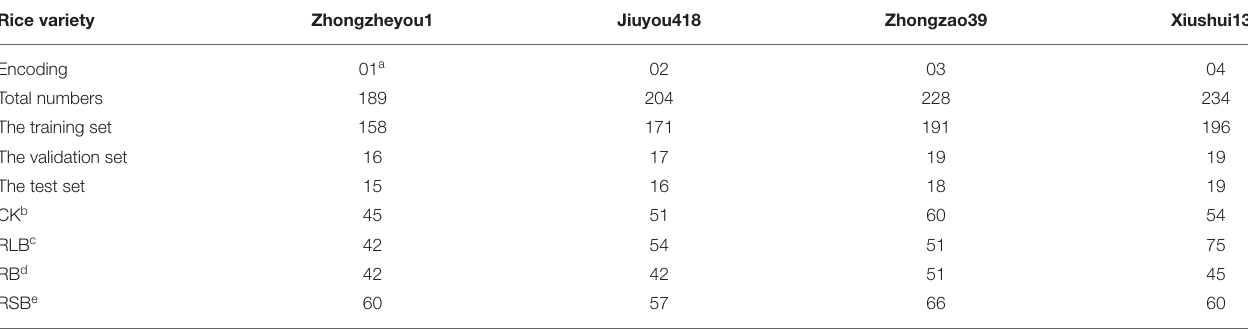
TABLE 1 | Rice varieties and their corresponding labels and sample